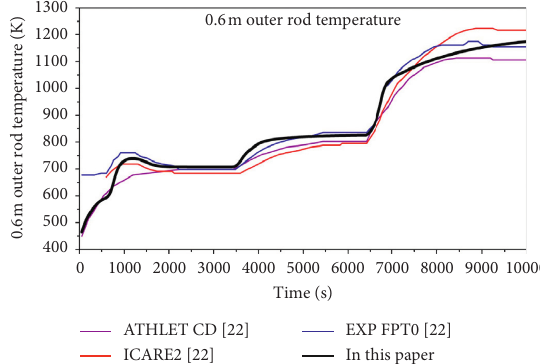
Figure 12: Variation of outer ring fuel rod temperature at 0.6m.